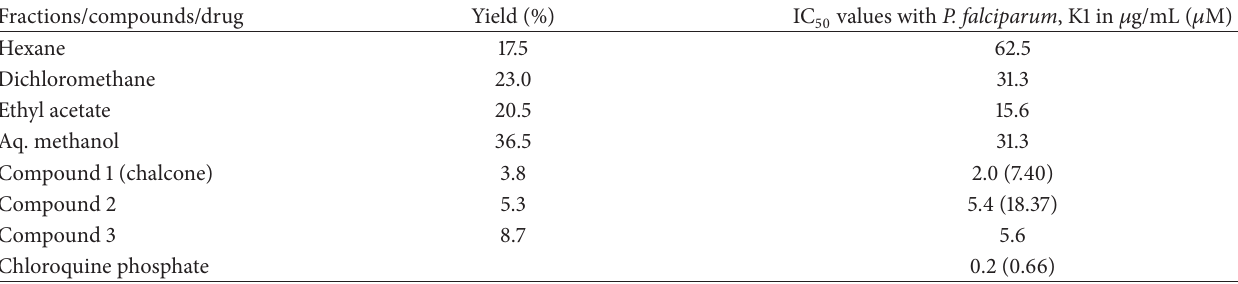
Table 1: Yield and in vitro antiplasmodial activity of Cajanus cajan leaf fractions and compounds.